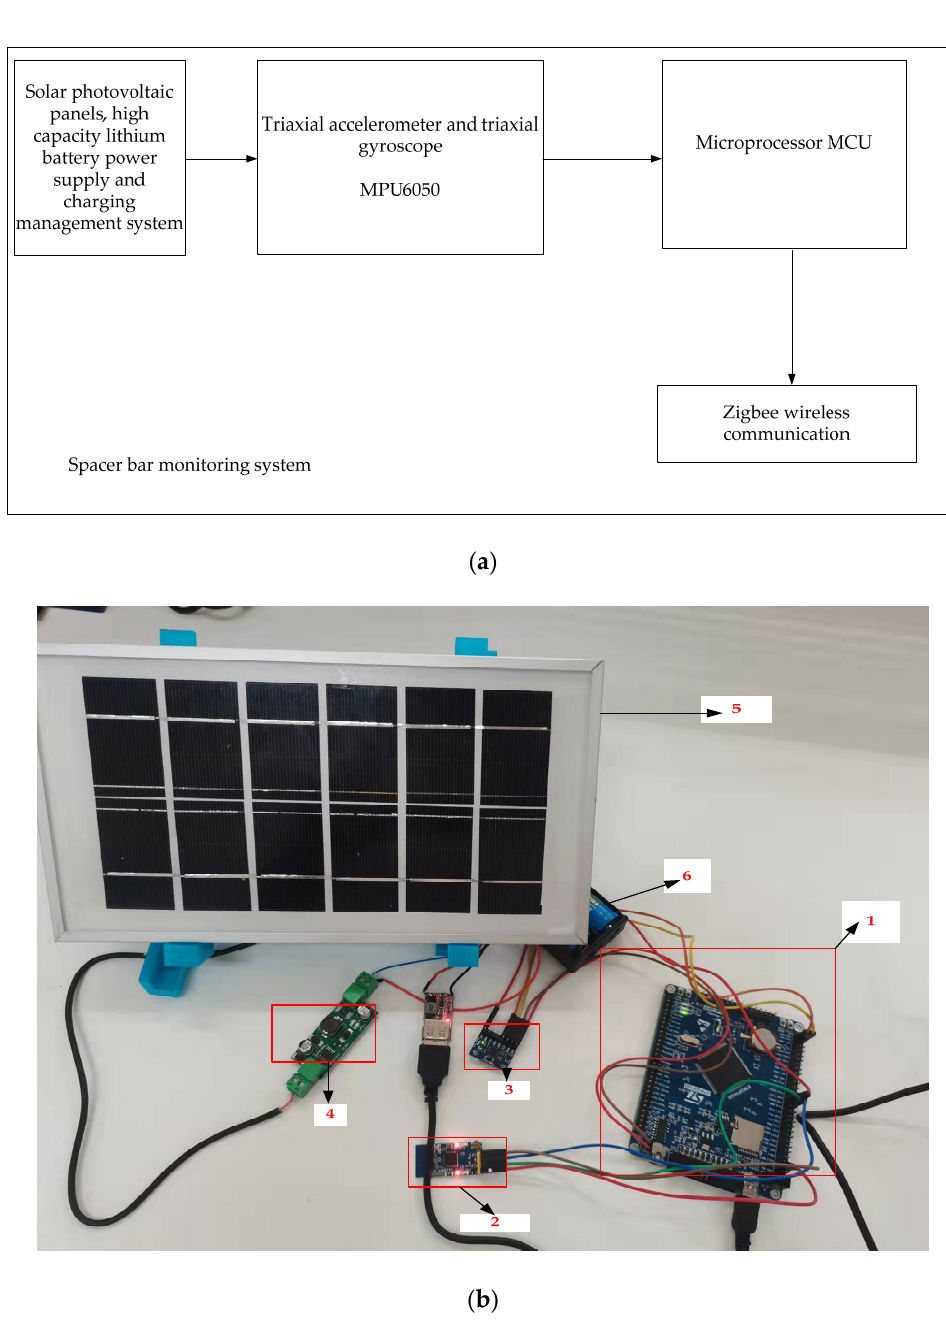
Figure 1. Structural block diagram and physical drawing of the on-line monitoring system. ( a ) Struc- tural block diagram of the on-line monitoring system; ( b ) Physical map of the on-line monitoring system.